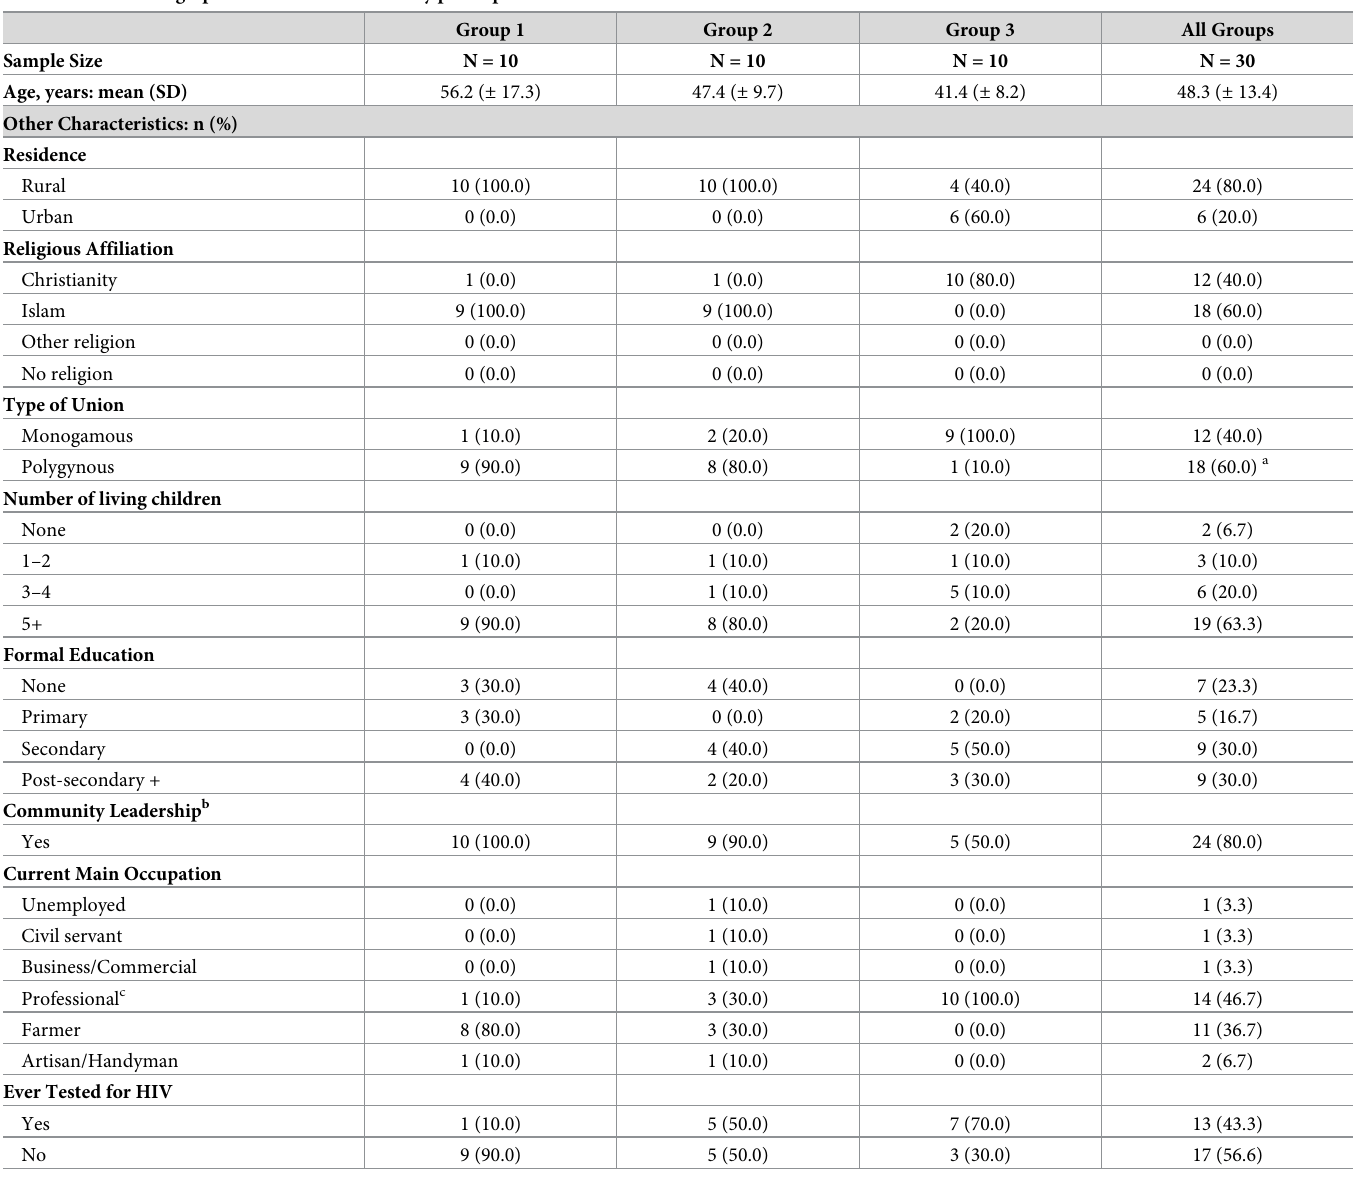
Table 1. Socio-demographic characteristics of study